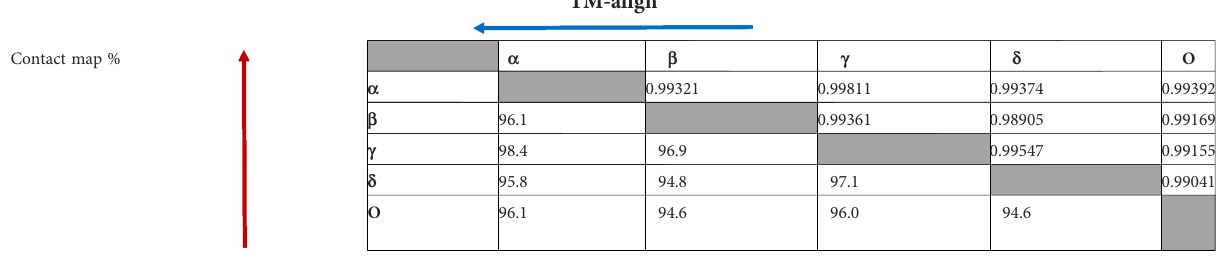
TABLE 3 Comparison of contact map percentage (red) and TM-align (blue) scoring between the different SARS CoV-2 VOCs. The arrowheads denote the variant used as a reference when calculating the data. Contact map